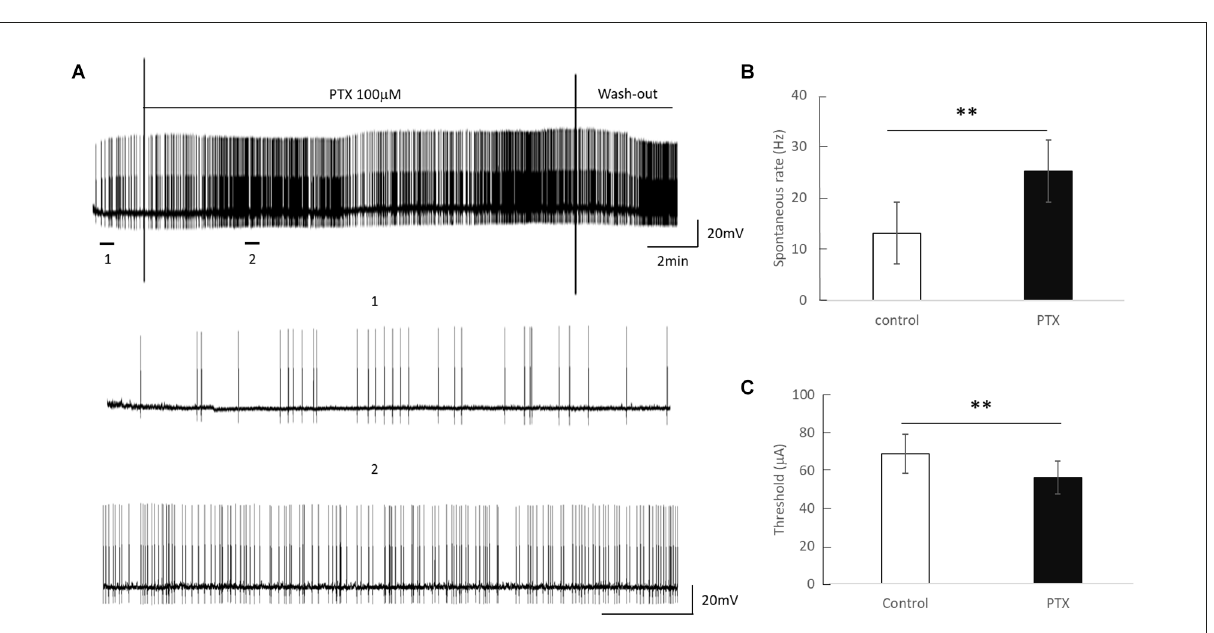
amplitudes. For 20 Hz stimulation ( Figure 5B ) no significant change in spike count was observed with PTX. These results indicate that PTX did not reduce desensitization. This is